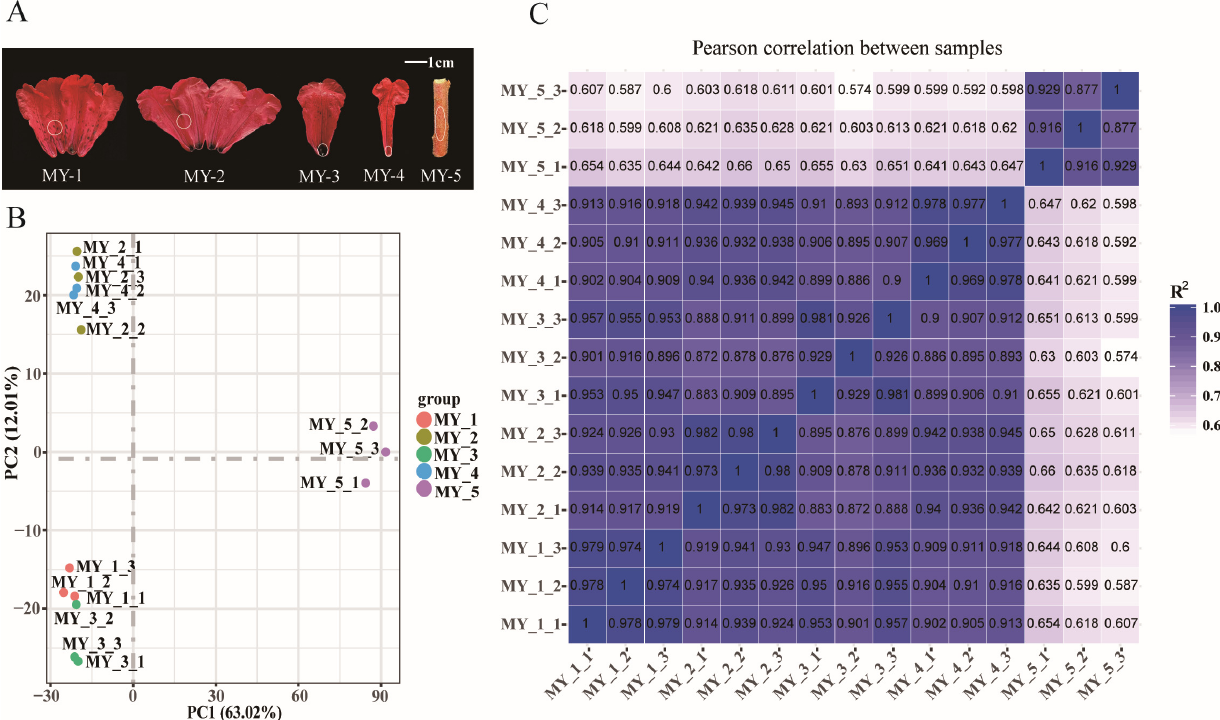
Figure 6. Basic transcriptome data of five types of red samples of R. delavayi spotted petals, unspotted petals, spotted throat, unspotted throat, and branchlet cortex. ( A ) Phenotypes of five types of samples of R. delavayi : MY-1, spotted petals; MY-2, unspotted petals; MY-3, spotted throat; MY-4, unspotted throat; MY-5, branchlet cortex. The enclosed part represents the sampling site. ( B ) PCA analysis of the five types of samples; ( C ) Pearson correlation coefficient of the five types of samples.